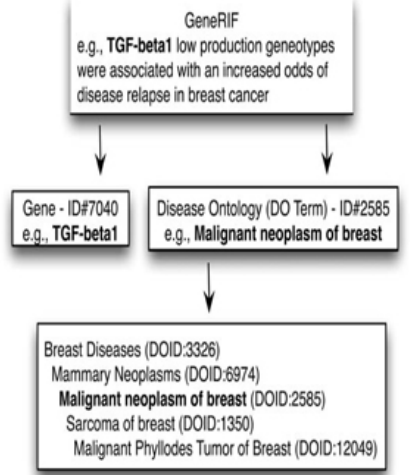
Figure 6: An example DO-GeneRIF mapping. Table 8: Annotation statistics related with disease